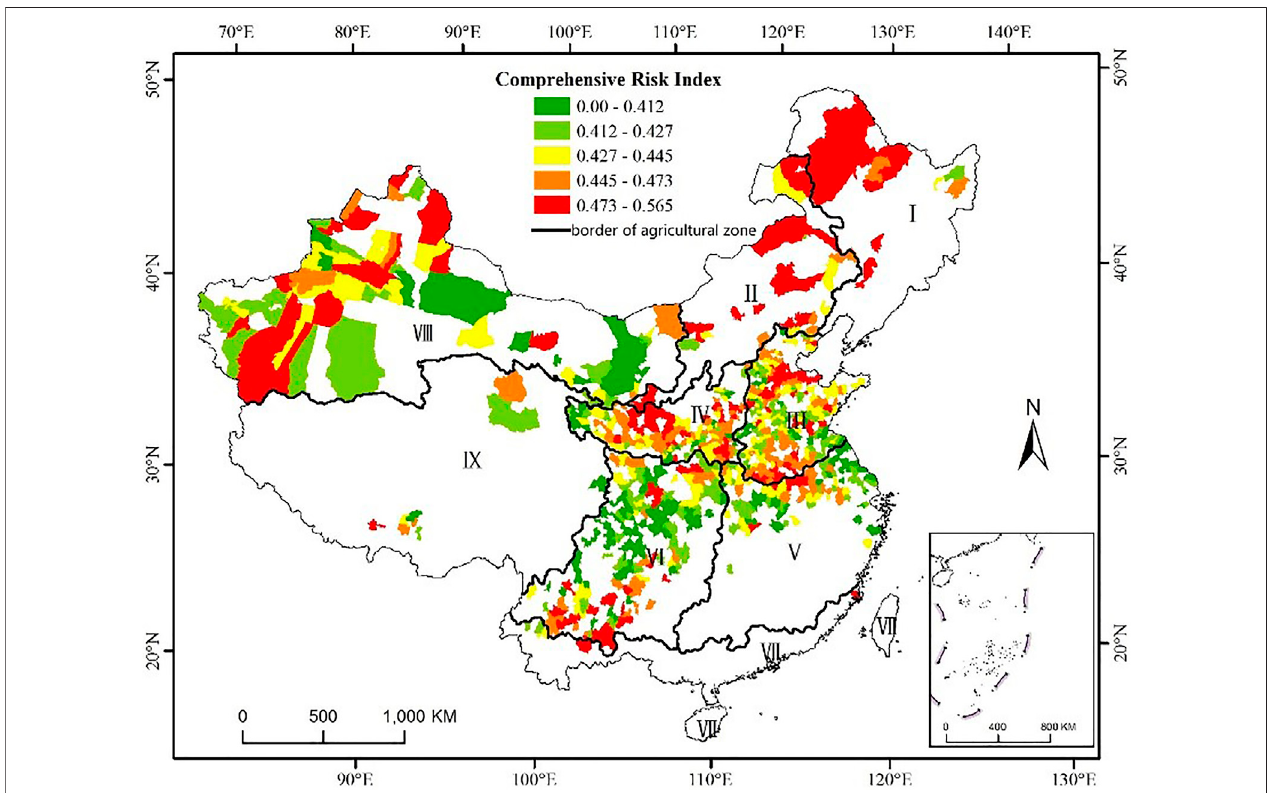
FIGURE 6 | Distribution of comprehensive risk index of wheat in main production regions from 1981 to 2010 without removing area effect (CRI).